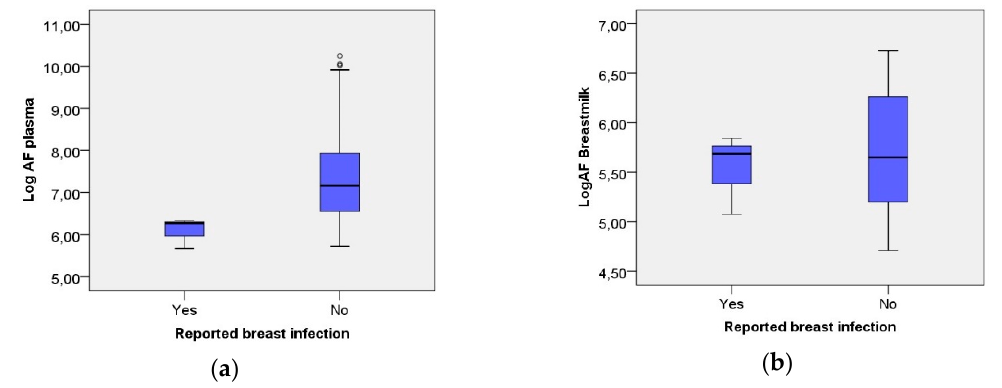
Figure 4. ( a ) Lower AF-levels in plasma related to having reported a breast infection ( n = 3) compared with not reporting a breast infection ( p < 0.05), unfilled circles indicate values 1.5 × IQR or more above the third quartile; ( b ) AF-levels in breast milk related to having reported breast infection ( n = 3) compared with not reporting a breast infection ( p > 0.05).